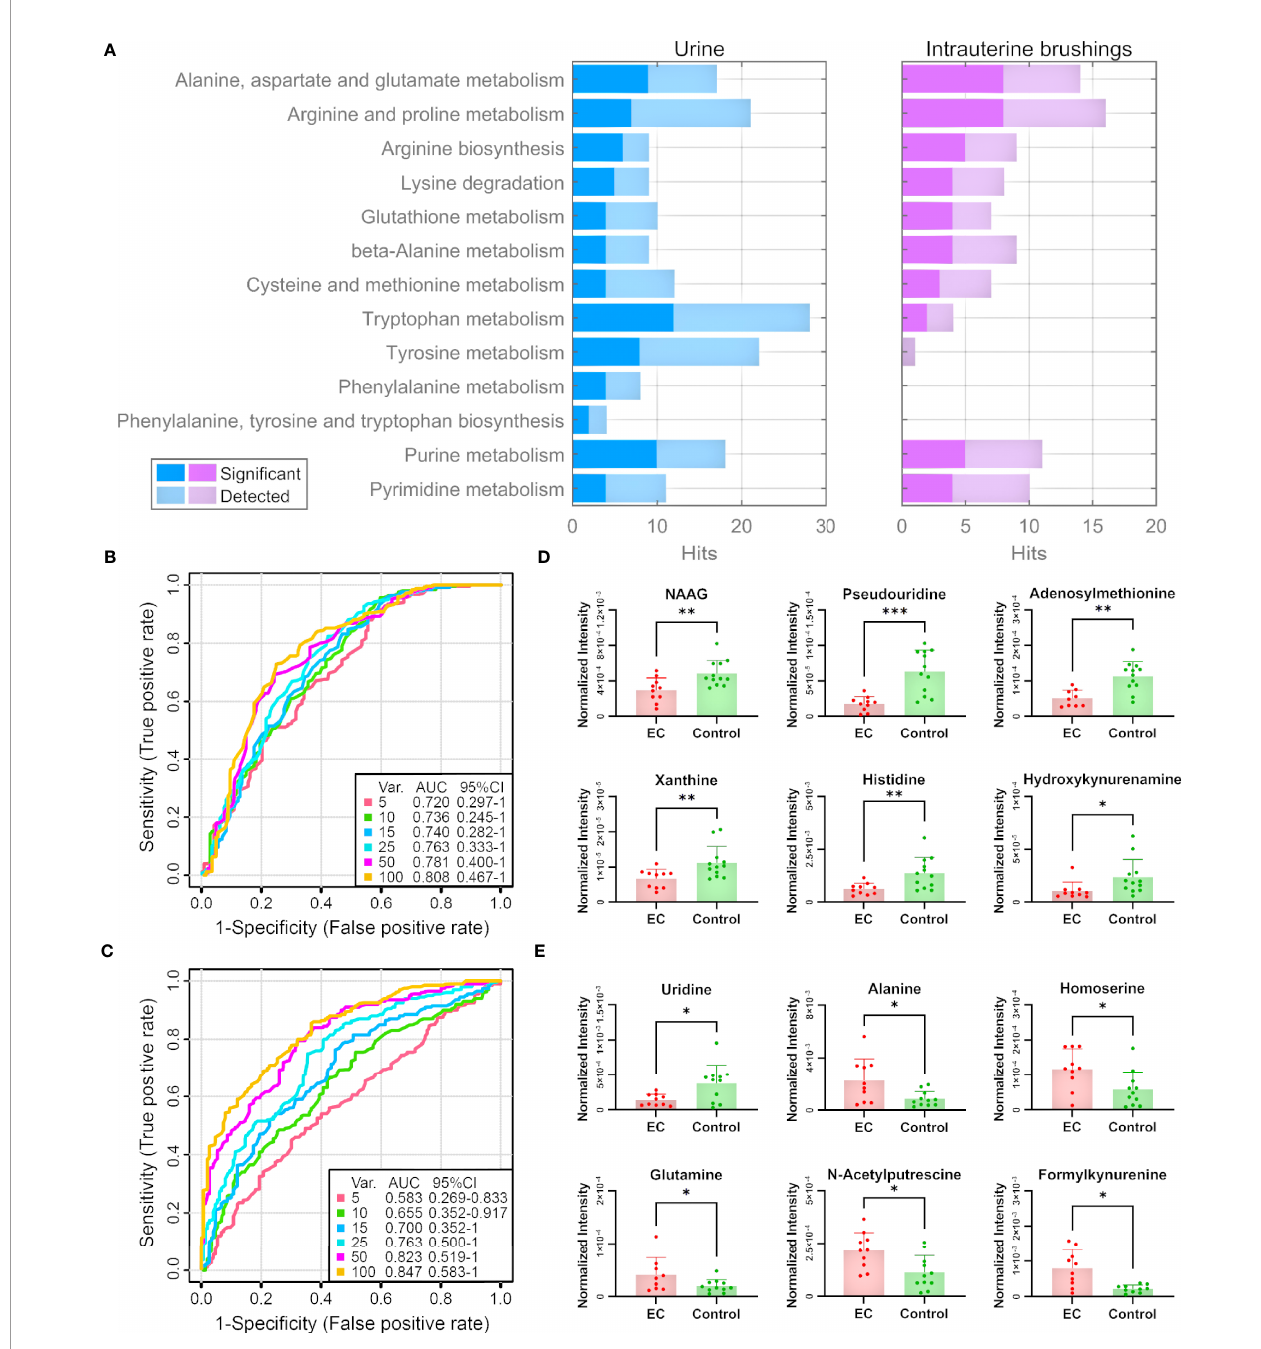
FIGURE 5 | Pathway and biomarker analyses with EC urine and intrauterine brushing samples based on the 13 selected pathways by the analysis of EC tissue samples. (A) Numbers of detected and signi fi cant metabolites ( p -values < 0.05 or VIP values > 1) from the urine and intrauterine brushing samples relating to the 13 selected pathways. (B, C) ROC curves for the classi fi cation of EC patients and controls using the metabolites detected in (B) urine and (C) intrauterine brushing samples relating to the 13 selected pathways. PLS-DA was used as the classi fi cation method, and 100 rounds of Monte Carlo cross-validation were performed to generate the ROC curve. Details are described in the “ Materials and Methods ” section. (D, E) The normalized intensity of representative metabolites detected in (D) urine and (E) intrauterine brushing samples relating to the 13 selected pathways. NAAG represents N-acetylaspartylglutamate. “ * ” , “ ** ” , and “ *** ” indicate p -values smaller than 0.05, 0.01, and 0.001, respectively. See also Supplementary Figures 12 , 13 for other signi fi cant